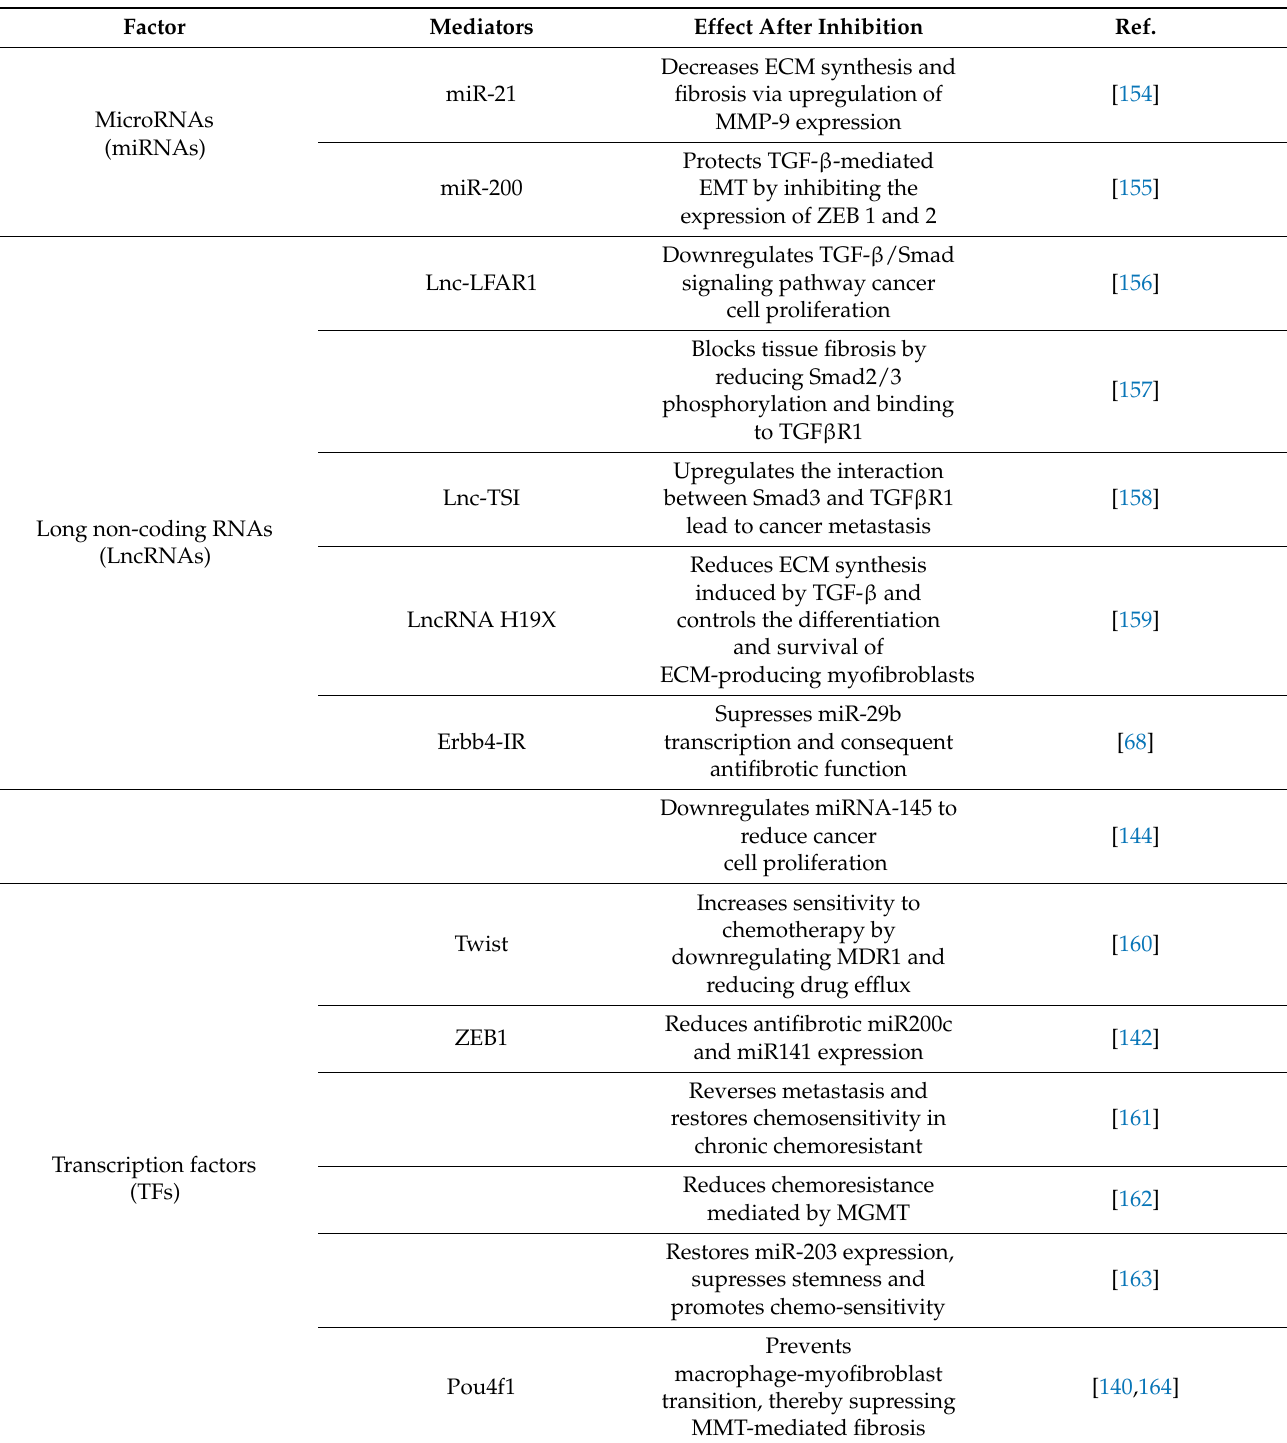
Table 2. The downstream therapeutic targets of TGF- β signaling in fibrotic